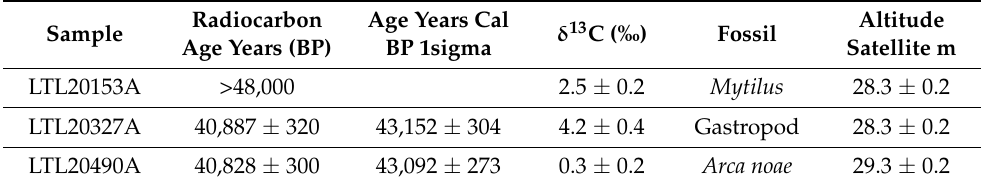
Table 2. Radiocarbon ages: samples at Cannitello 1 site; see also Figures 5 and 6.